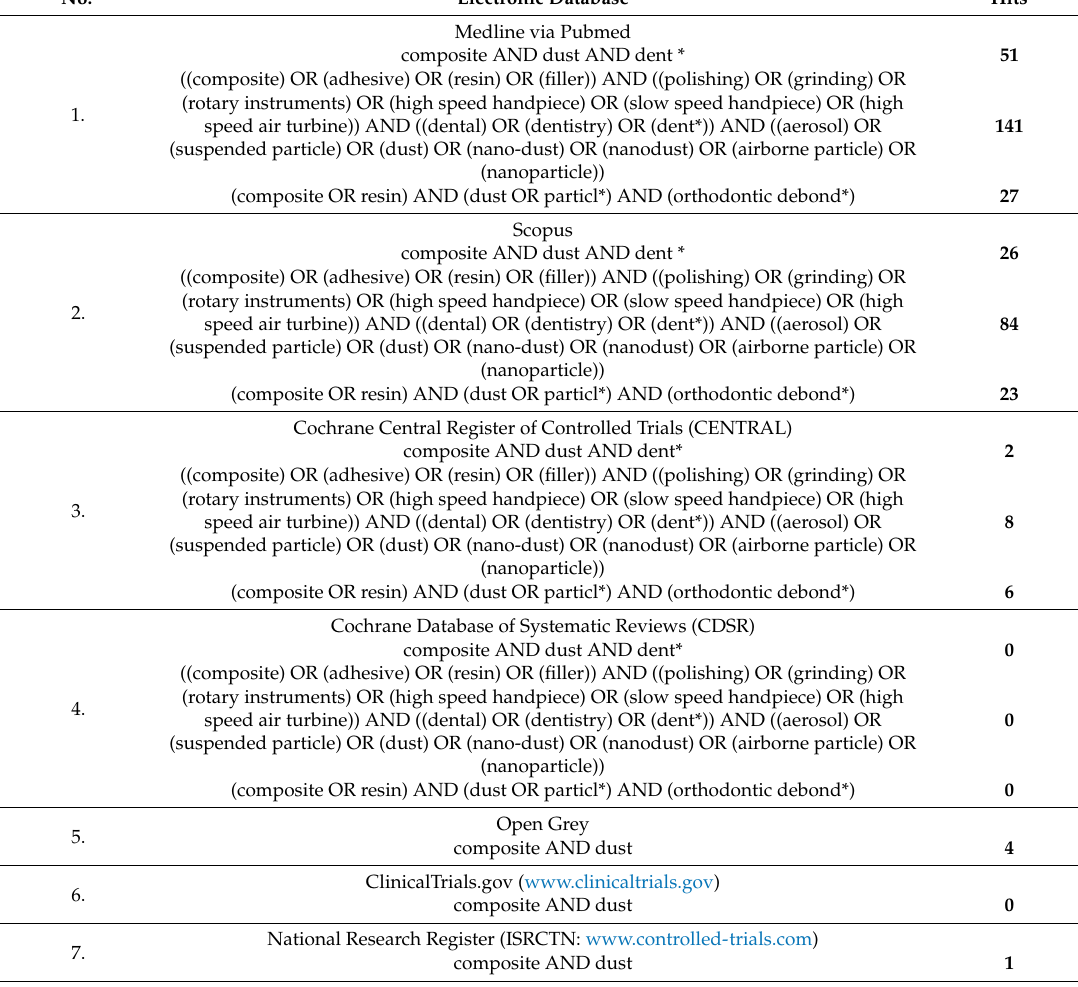
Table A1. Detailed search strategy across